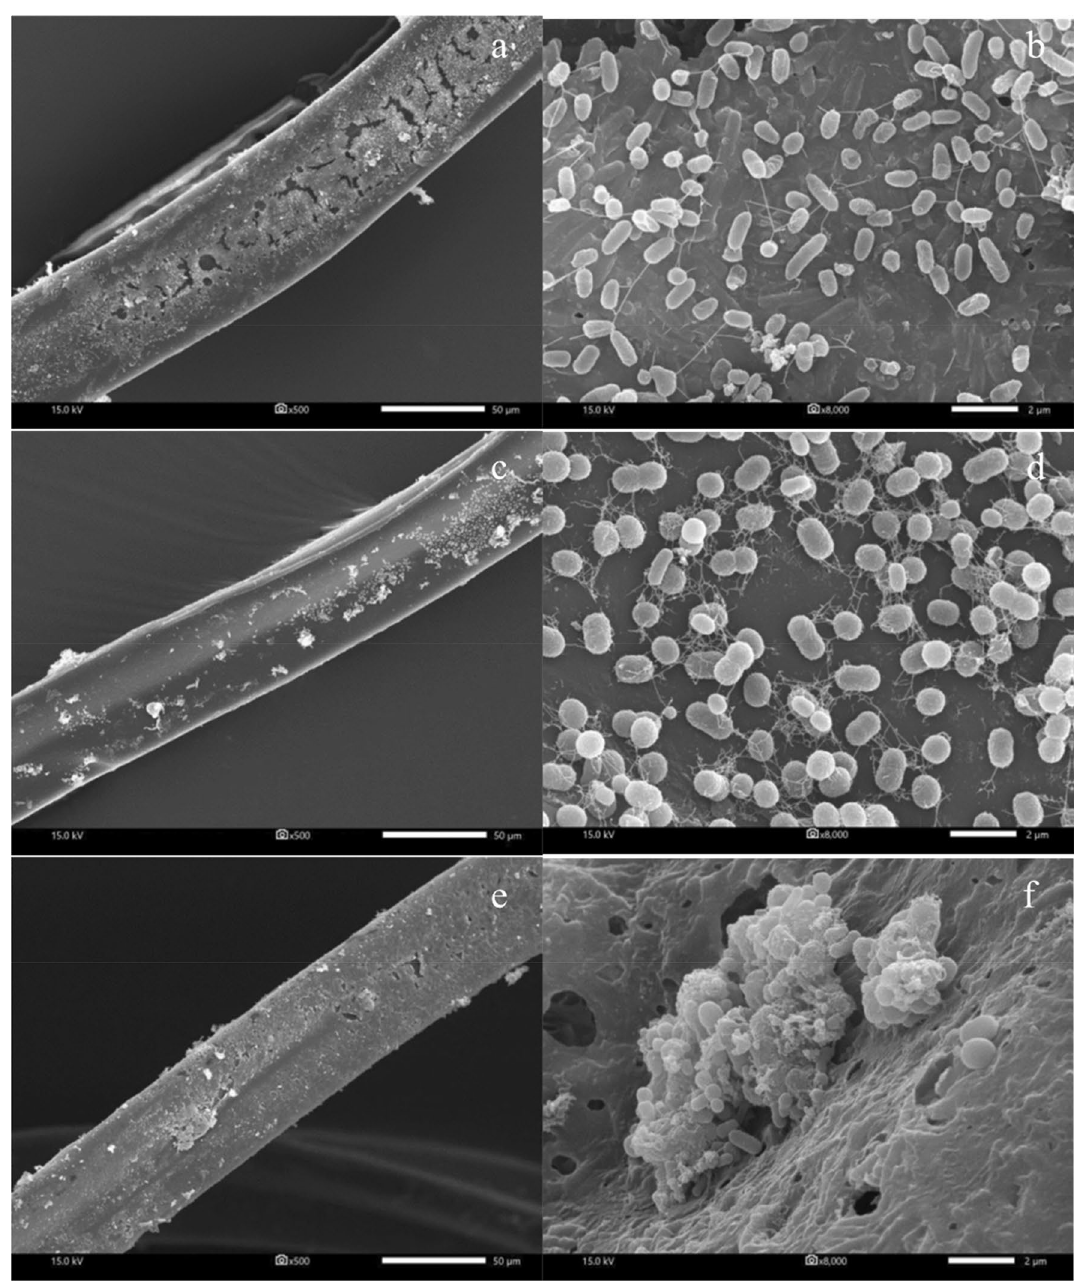
Figure 4. SEM micrograph of the surface of bio-cord colonized with Exiguobacterium sp. AO-11 at 500 × (left) and a close-up SEM micrograph of the bio-cord surface with Exiguobacterium sp. AO-11 attached at 8,000 × (right) after reuse for 1 ( a , b ), 3 ( c , d ) and 5 ( e , f )